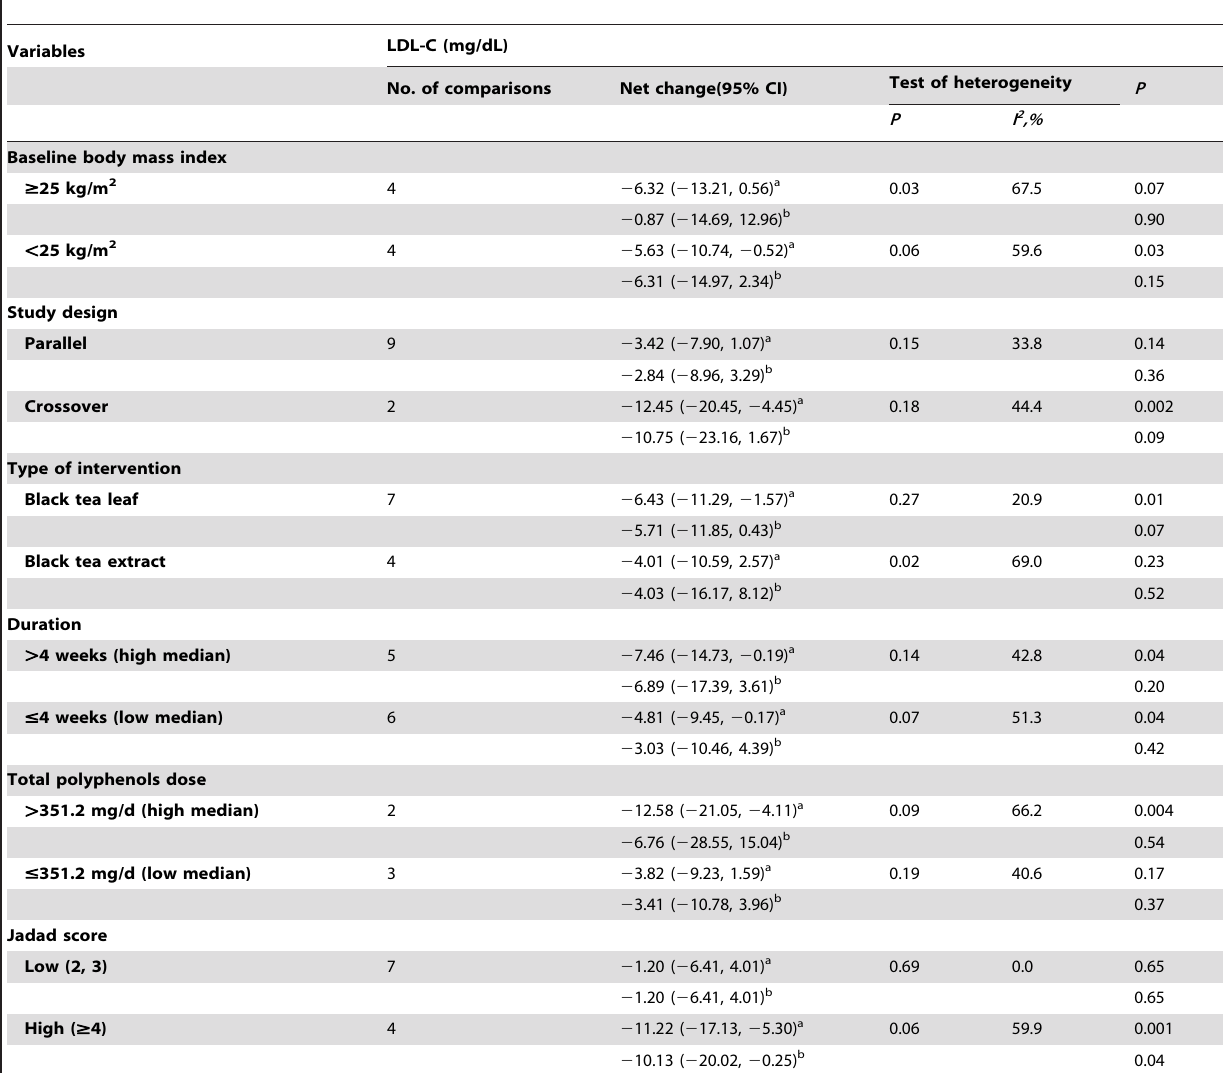
Table 4. Subgroup analyses of effect of black tea on LDL-C concentrations in healthy subjects stratified by previously defined study